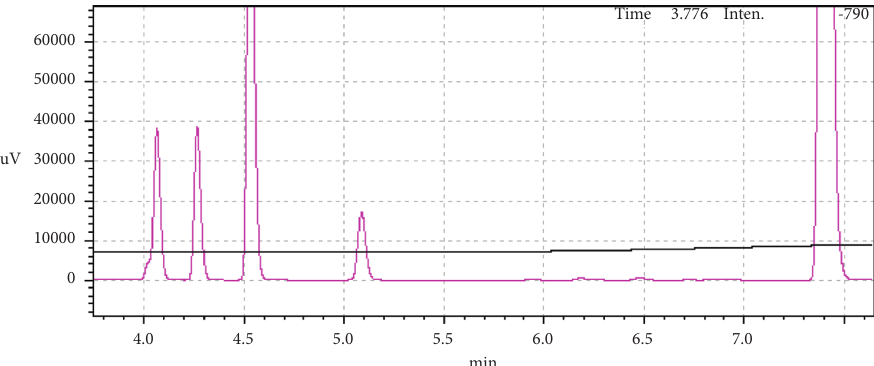
Figure 5: Chromatogram of standard showing low carryover